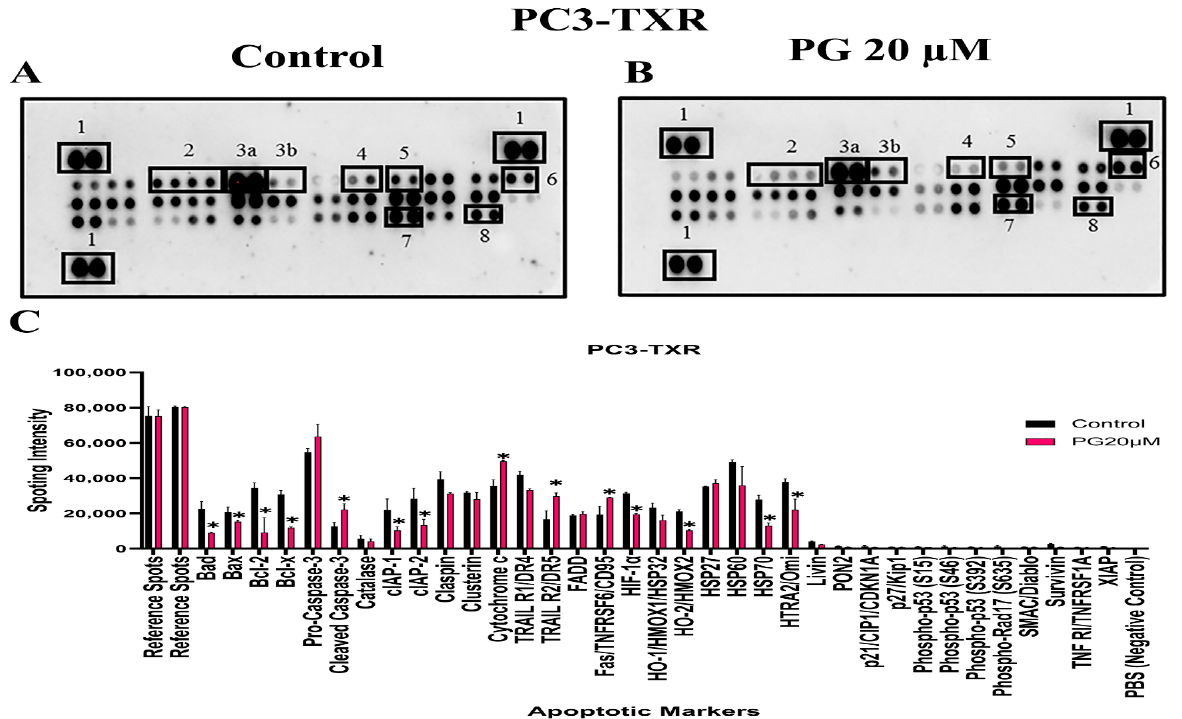
Figure 12. PG modulates the expression of various apoptotic markers in PC3-TXR. Figure ( A ) represents PC3-TXR control and ( B ) represents PC3-TXR treated with PG 20µM, in which the cells were seeded and treated with PG 20 µM for 48 h. Expression of the various apoptotic markers was found using a proteome profiler-human apoptosis array. PG promotes downregulation in the antiapoptotic markers Bcl-2, Bcl-xL, and IAP family, in addition to an upregulation in cytochrome c and cleaved-caspase-3. Numbers used to depict the expression of selected markers compared to reference spots: 1 = reference spot, 2 = Bcl family, 3a = pro-caspase 3, 3b = cleaved caspase 3, 4,5,8 = IAP family, 6 = cytochrome c, 7 = survivin. ( C ) represents the quantified results of the relative band intensities calculated using ImageJ, and relative expression levels were plotted against PG treatment. Data are represented as mean ± SD. * p < 0.05.